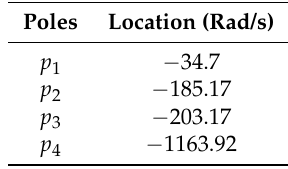
Table 2. Pole values of the closed-loop system for the control of the voltage v DC 2